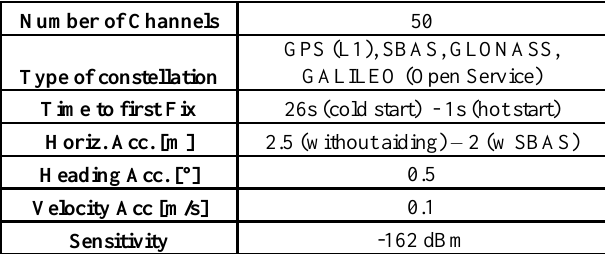
Figure 2. In this case a GPS u-blox 6H has been embedded. The main performance of this GPS module are reported in Table 1 (Piras et al., 2010).